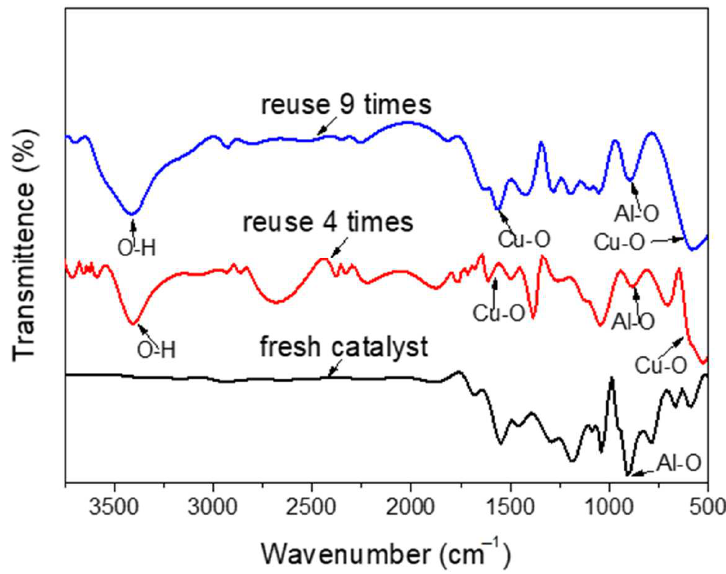
Figure 11. FT-IR spectrum of Cu 2 O/Al 2 O 3 coating after reuse 0, 4, and 9 times. With the increase of reuse times, a wide peak appeared in the range of 20–30°. The